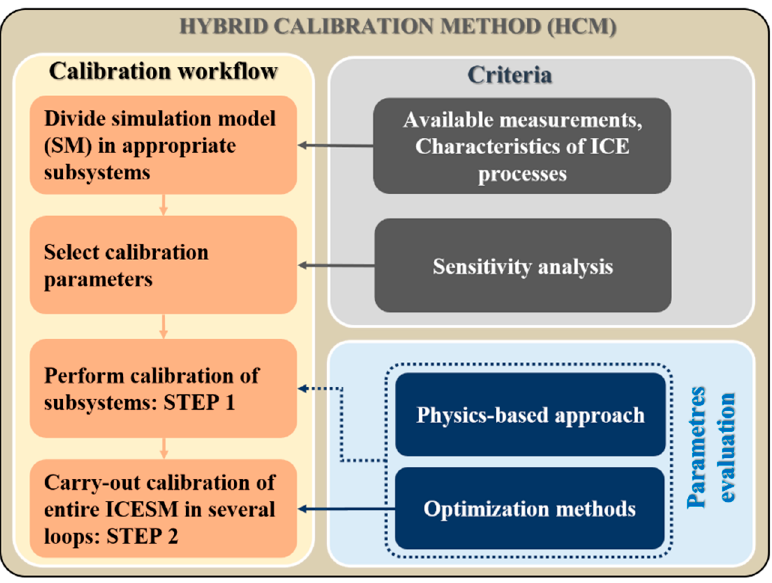
Figure 4. Proposed calibration workflow of the ICESM presented in Figures 1 and 2.